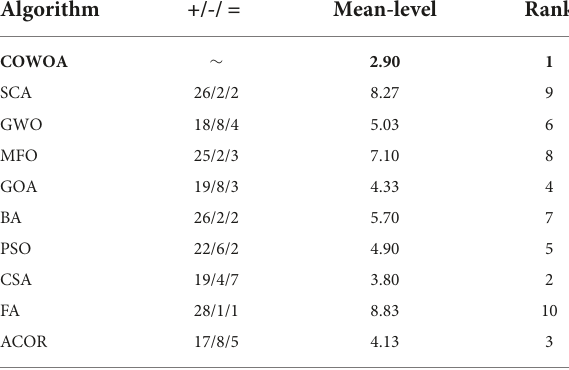
TABLE 9 Results of Wilcoxon signed-rank